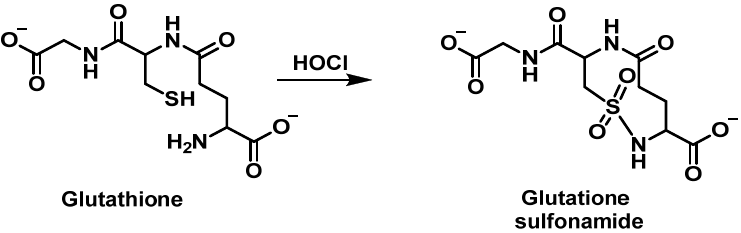
Figure 36. Reaction of GSH with HOCl and formation of glutathione sulphonamide. The possible mechanism for this transformation is shown in Figure 37.